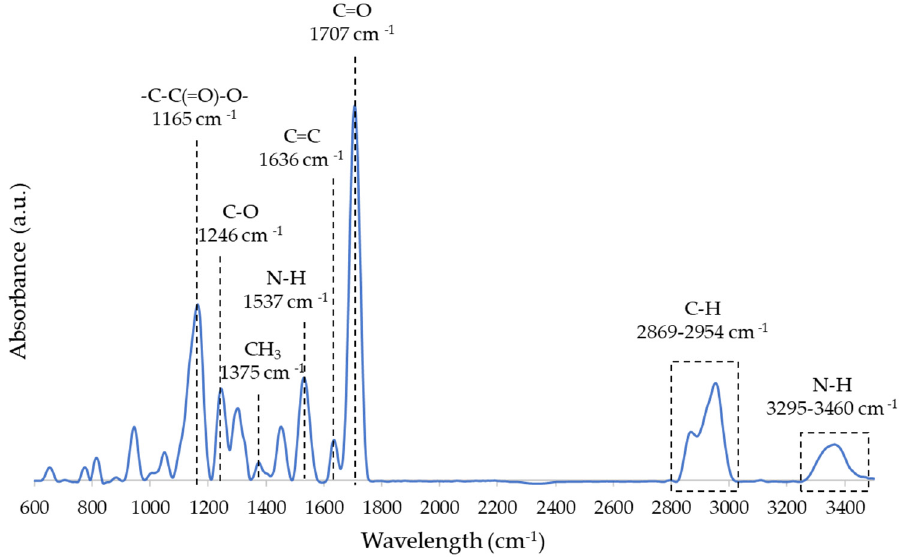
Figure 1. FTIR spectrum of acrylic resin.